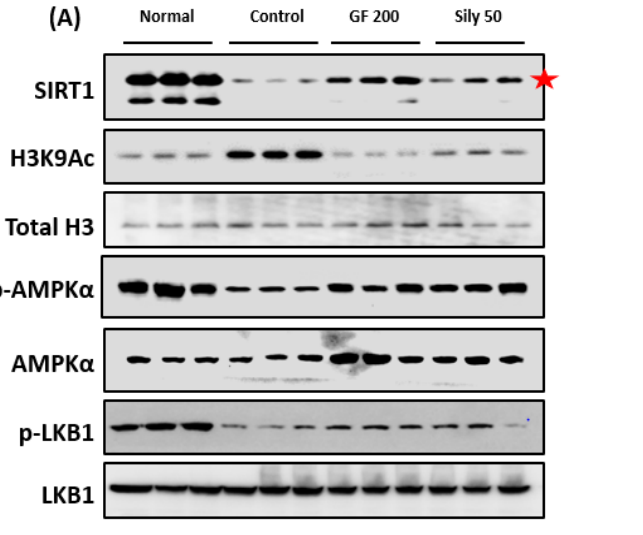
Figure 5. GF ameliorates liver fibrosis via regulations of AMPK/SIRT1 signaling pathways. Western blot analysis of SIRT1 and its deacetylate target proteins such as H3K9Ac, Total H3, p-AMPK α , and AMPK α , p-LKB1, and LKB1 ( A ), and NOX2, p47 phox , Nrf2, and HO-1 ( B ). ( C ) Quantification analysis of Western blot analysis. Data were expressed mean ± SEM ( n = 3 for each group for Western blot analysis). ## p < 0.01 and ### p < 0.001 for Normal vs. Control; * p < 0.05 and ** p < 0.01 for Control vs. GF 200 or Sily 50.